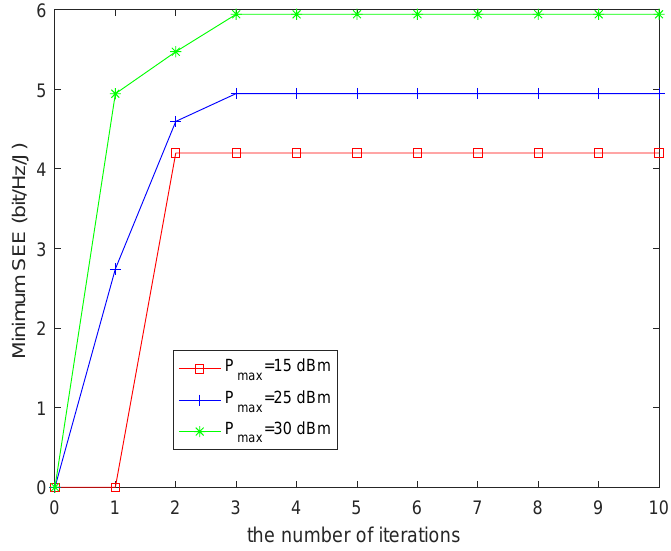
Figure 4. The convergence performance of the different BS transmit